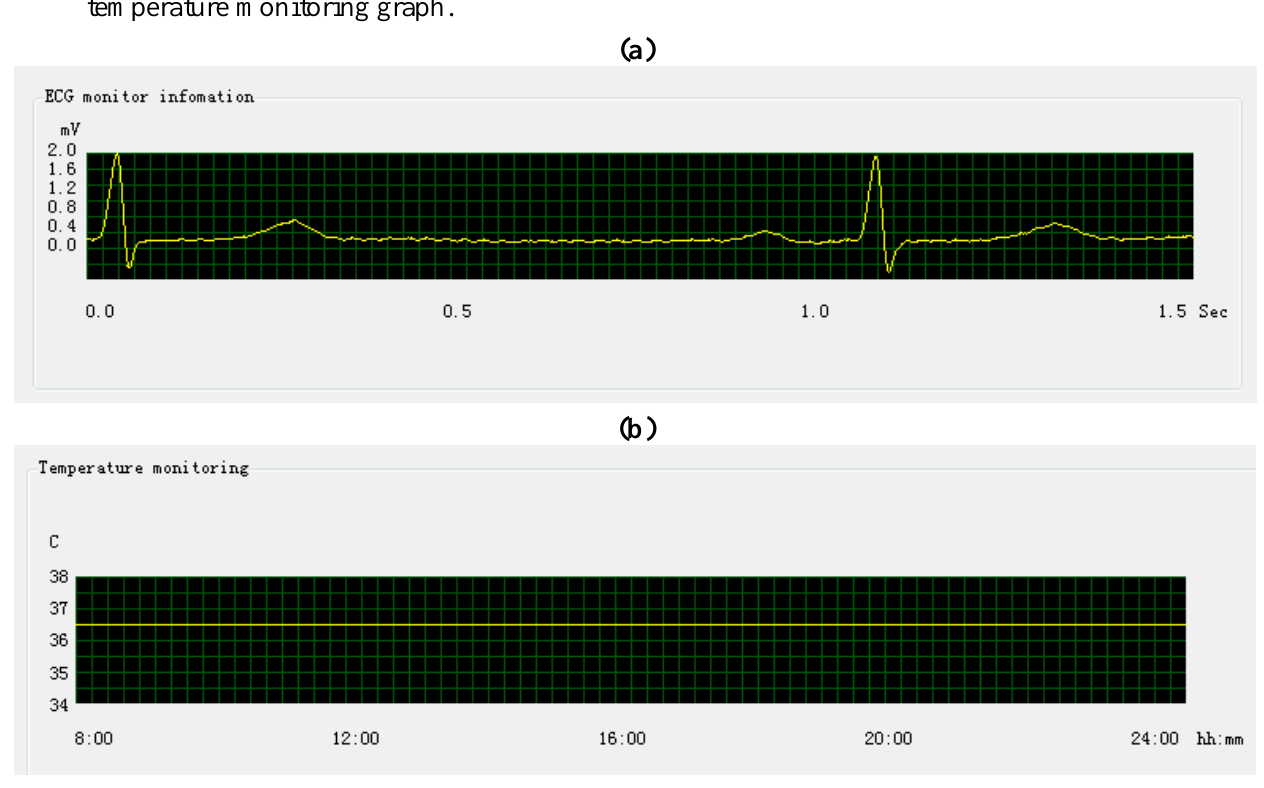
Figure 13. The ECG and temperature monitoring. (a) The ECG monitoring graph; (b) The temperature monitoring